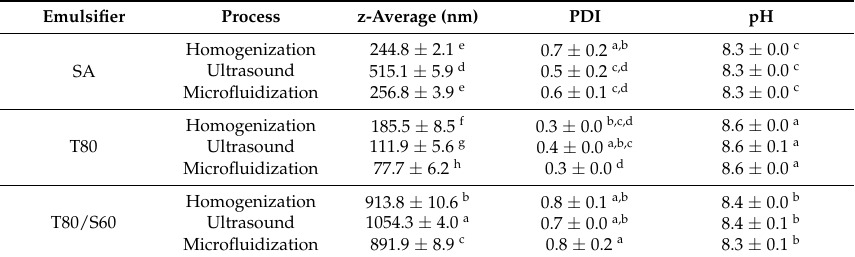
Table 1. Average droplet size (z-average) and polydispersity index (PDI) of BW–starch nanoemulsions.